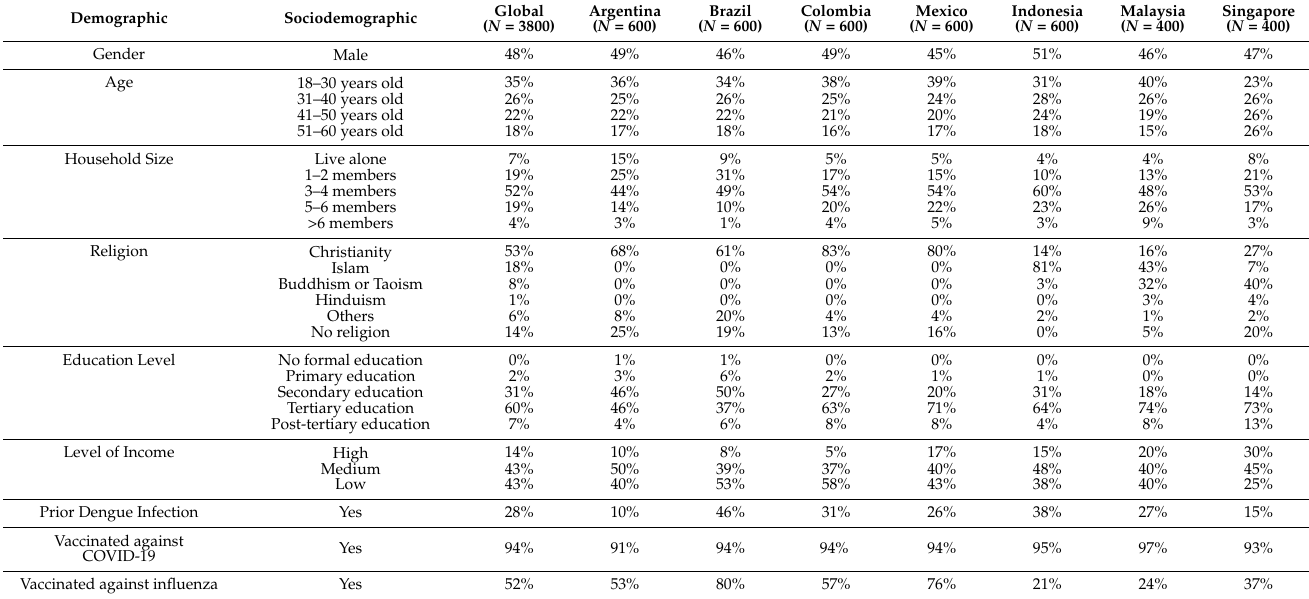
Table 1. Sociodemographic characteristics of study respondents globally and by